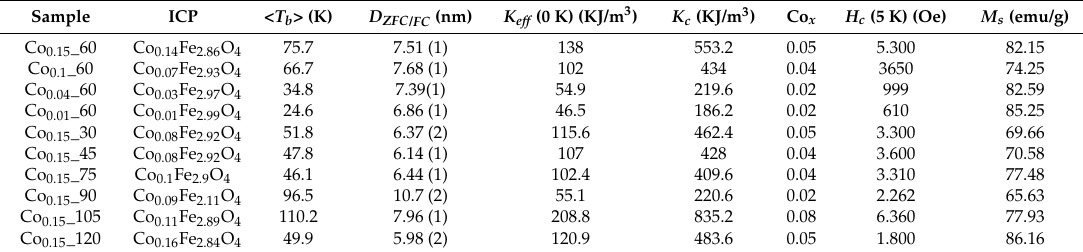
Figure 4. Temperature dependence of ZFC and FC magnetizations for samples Co x _ t for different ( a ) reflux times and ( b ) Co concentrations, measured at a magnetic field of 10 Oe. Table 2. Formula obtained from ICP calculations, average blocking temperature (< T B >), apparent magnetic diameter ( D ZFC/FC ), anisotropy constant K eff , (0 K) calculated from Equation (2), magneto-crystalline anisotropy K c , calculated cobalt content (Co x ) from K c values, coercive field ( H c ) and magnetization saturation at 250 K ( M s ) for Co x _ t synthetized samples.